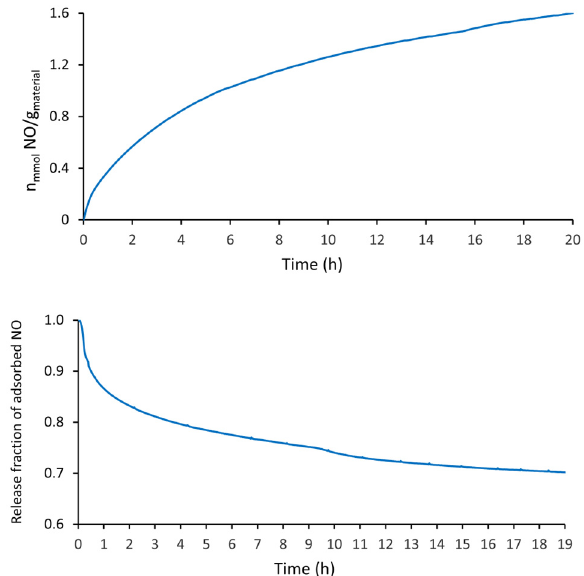
Figure 5. NO adsorption capacity of i-POF. Kinetic profiles at 80 kPa ( top ); NO release profiles under vacuum ( bottom ).